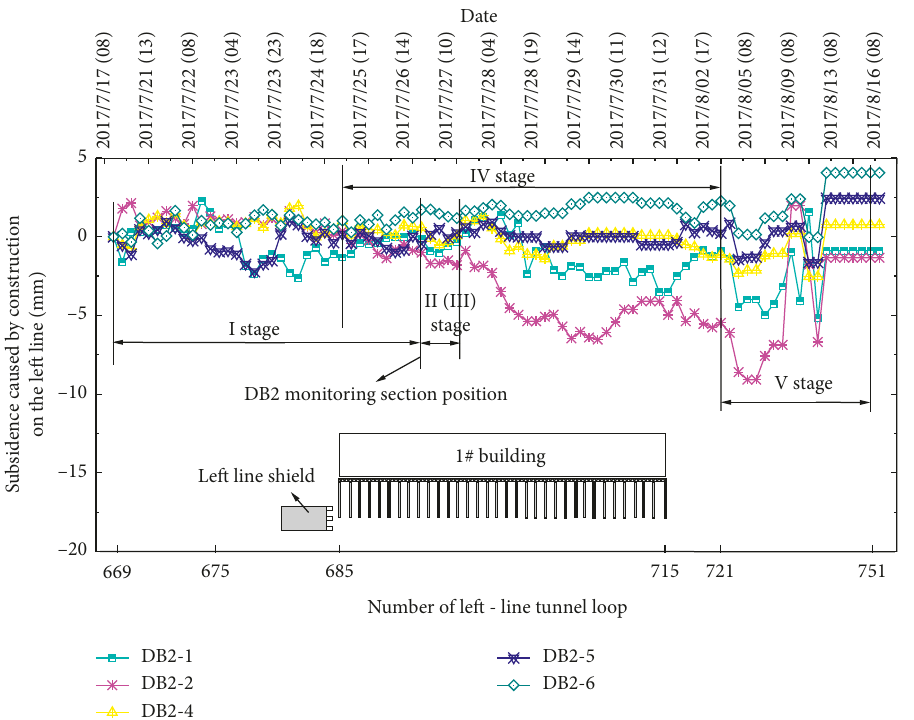
Figure 9: Monitoring time-history curve of surface subsidence of section